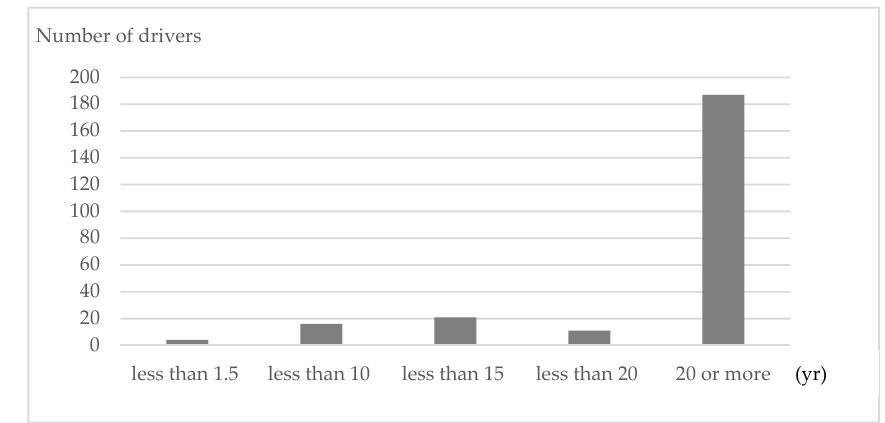
Figure 1. Driving experience of drivers in the survey.